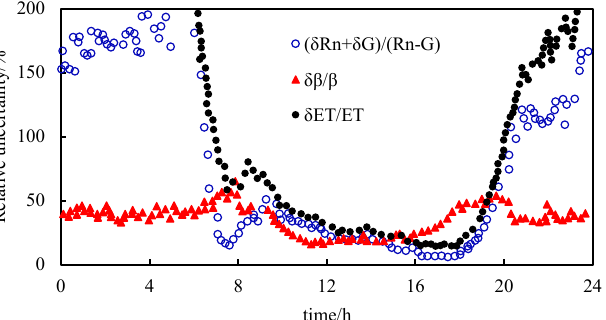
Figure 8. Uncertainty analysis for the determination of ET using the Bowen ratio energy balance method .